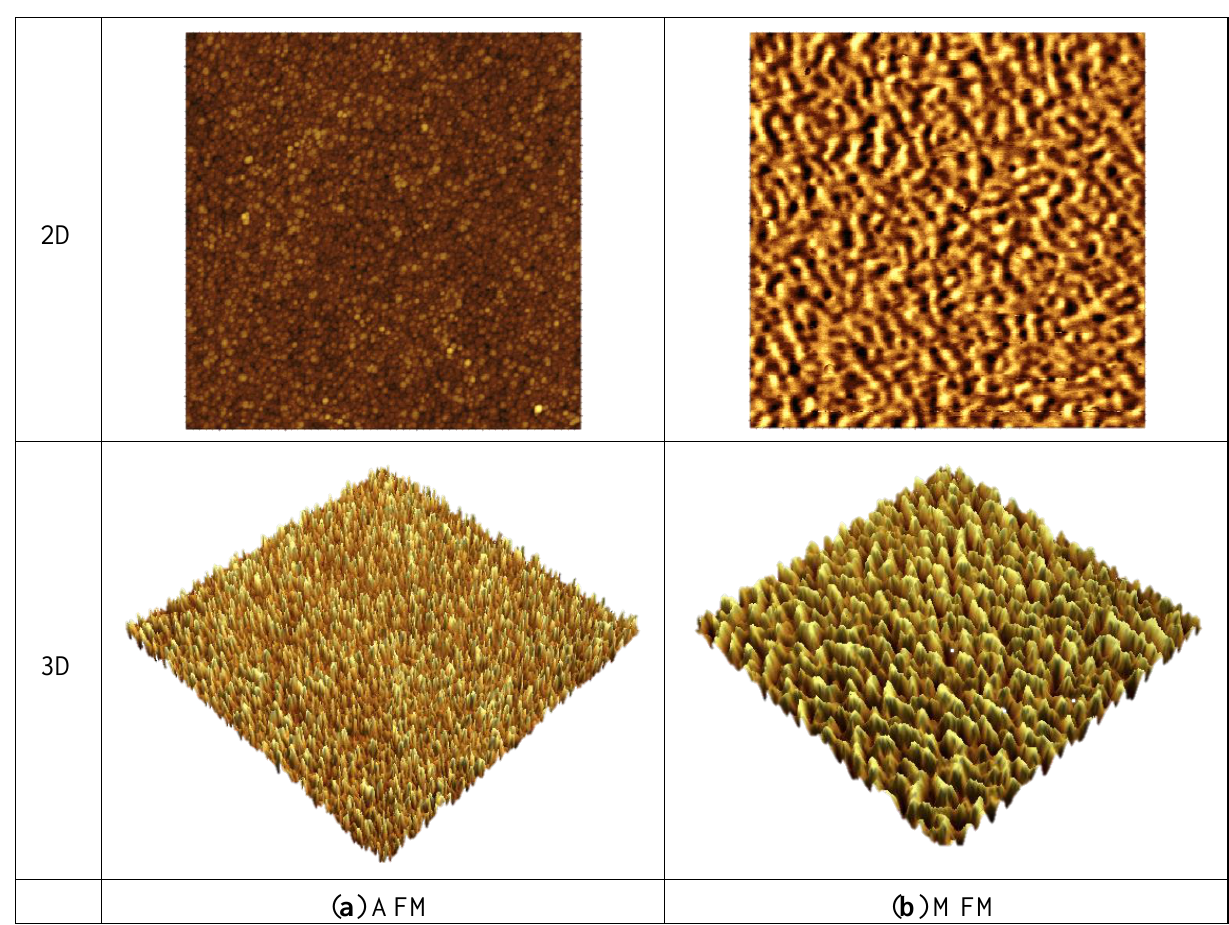
Figure 5. AFM and MFM images of FeNi thin film. ( a ) AFM images in 2D and 3D; ( b ) MFM images in 2D and